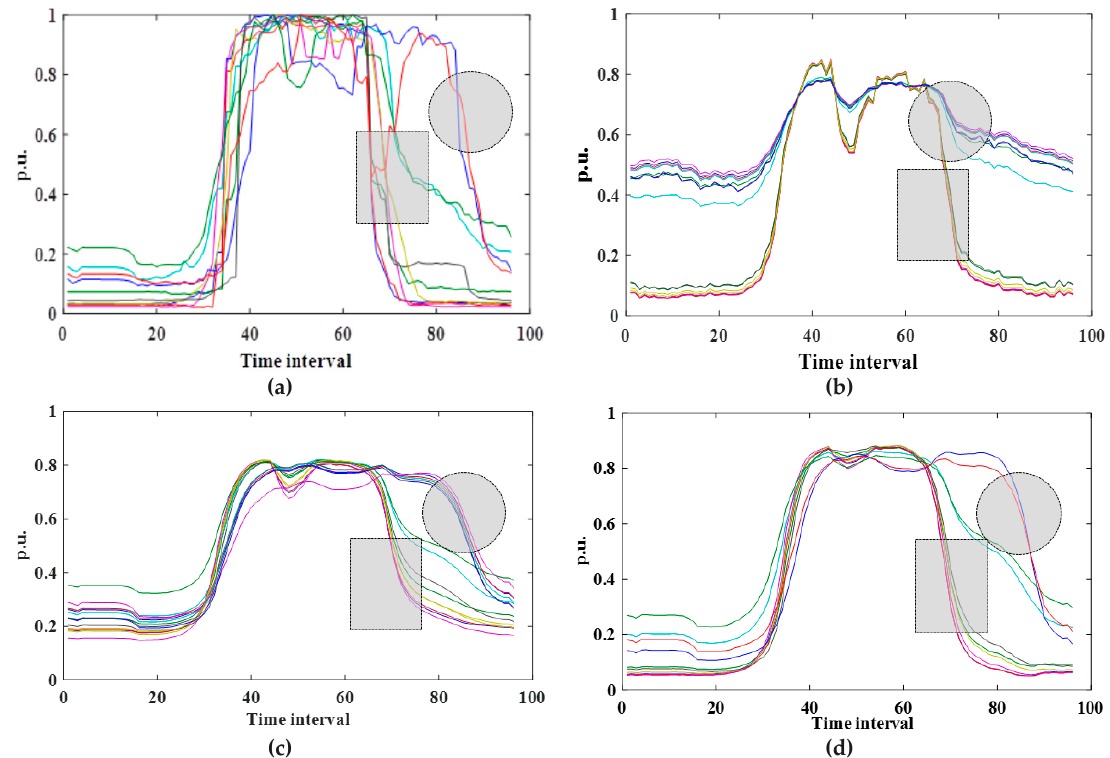
Figure 6. (a) Original 15 load profiles in case1; (b) Reconstructed load profiles by AE(96/20,50); (c)